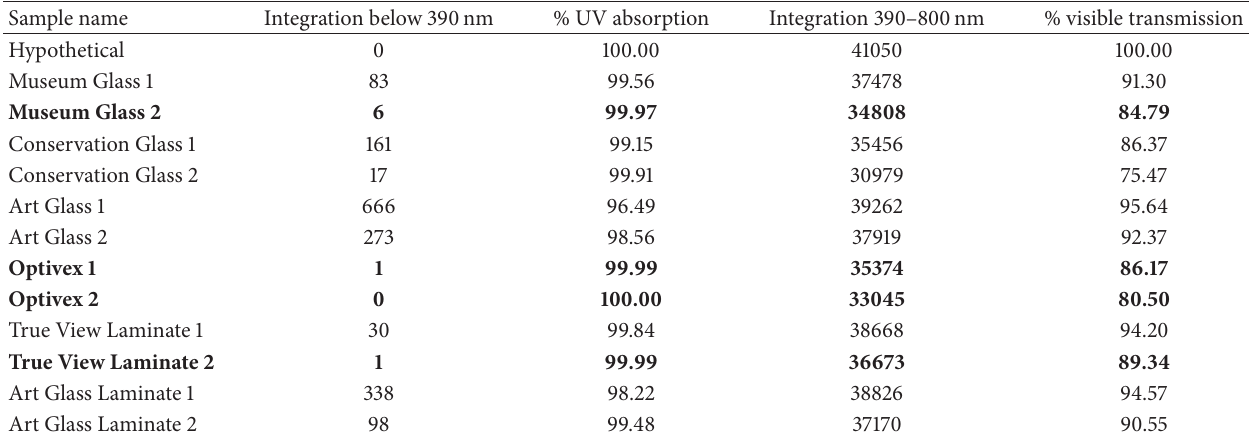
Table 1: The integrated area of the transmission below and above the 390 nm cutoff. The best 4 performing samples are highlighted in bold > 99.95% UV blocking.